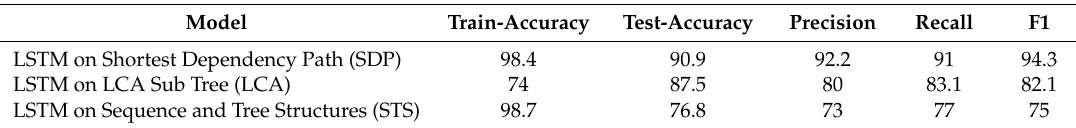
Table 6. Precision, recall, and F1 scores of the RE models.